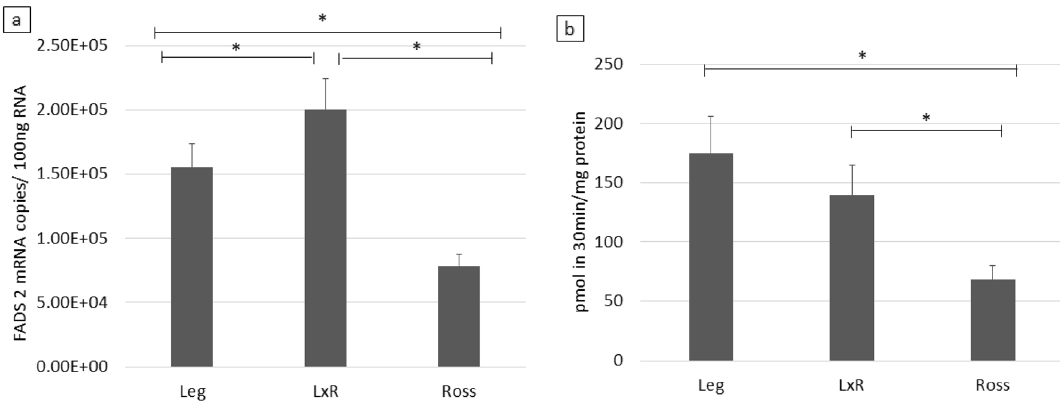
Figure 7. mRNA expression of FADS2 gene (mRNA copies/100 ng RNA; ( a ) and Δ6-desaturase activity (pmol in 30 min/mg of protein; ( b ) of liver. Leg: Leghorn genotype; LxR: crossbreed, Ross: Ross 208 genotype. *P < 0.05 (post hoc Tukey’s test).